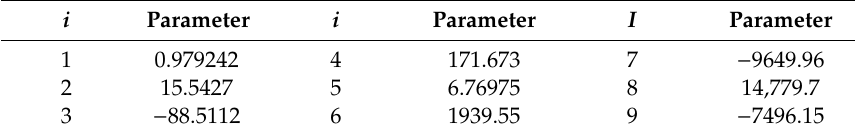
Table 4. Parameters for Equation